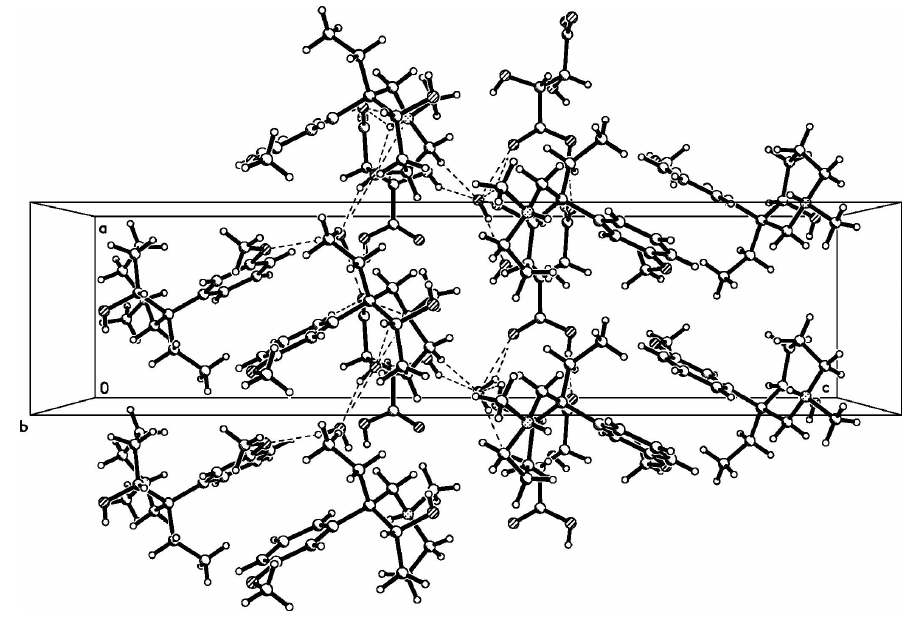
A view of the crystal packing, showing the hydrogen-bonding network (dashed lines). Only the twist-chair conformation of the azepane ring is